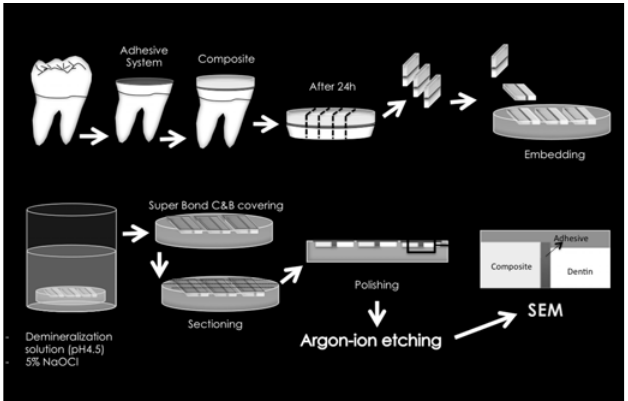
Fig. 1. Schematic illustration of the specimen preparation for